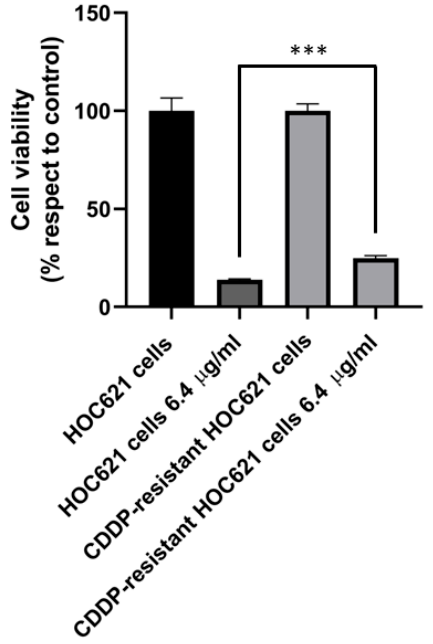
Figure 8. Impact of chemotherapeutic drugs on cell viability of OSCC cells. MTT assay was used to evaluate the effect of CCDP treatment (6.4 μ g/mL) on cell viability of selected CDDP ‐ resistant HOC621 and parental cells. Measurements were performed at 48 h and results were reported as percentage of the control (control equals 100% and corresponds to the absorbance value of each sample grown in DMEM at 48 h time point). All values are expressed as mean ± standard deviation (*** p < 0.005).